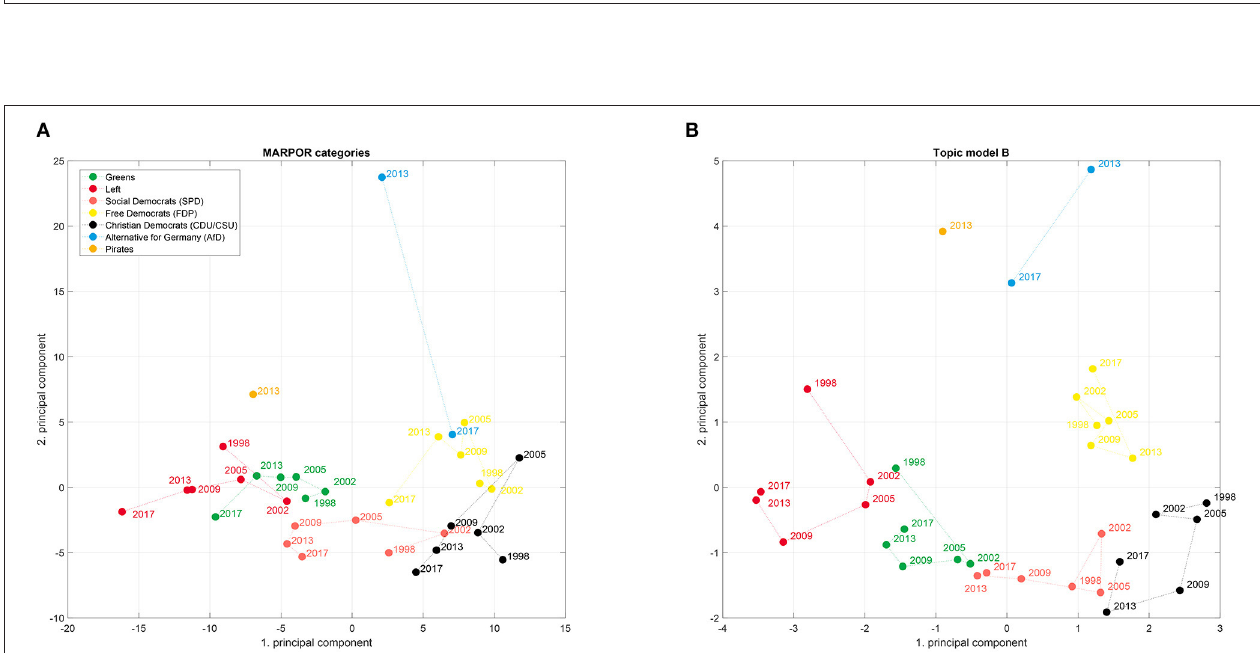
FIGURE 2 | Projection on the 2-days political space with the economic and cultural axis spanned by the difference between the economic and cultural left and right categories, respectively (see Table 5) of the German parties between 1998 and 2017.